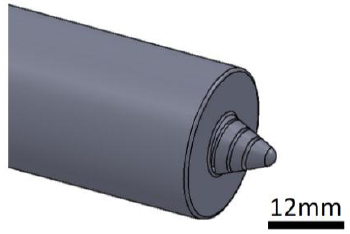
Figure 3. Shape of the welding tool designed in this work.